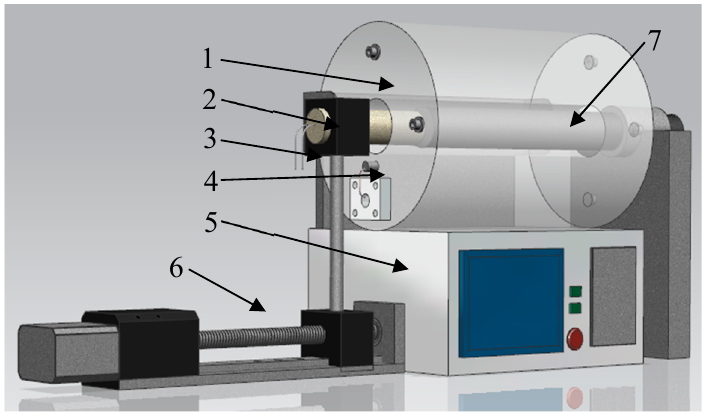
Figure 12. Hightemperature calibration setup. (1—heater,2—sensor,3—sensor lead wire, 4—thermocouple, 5—temperature controller, 6—position adjuster, 7— target).